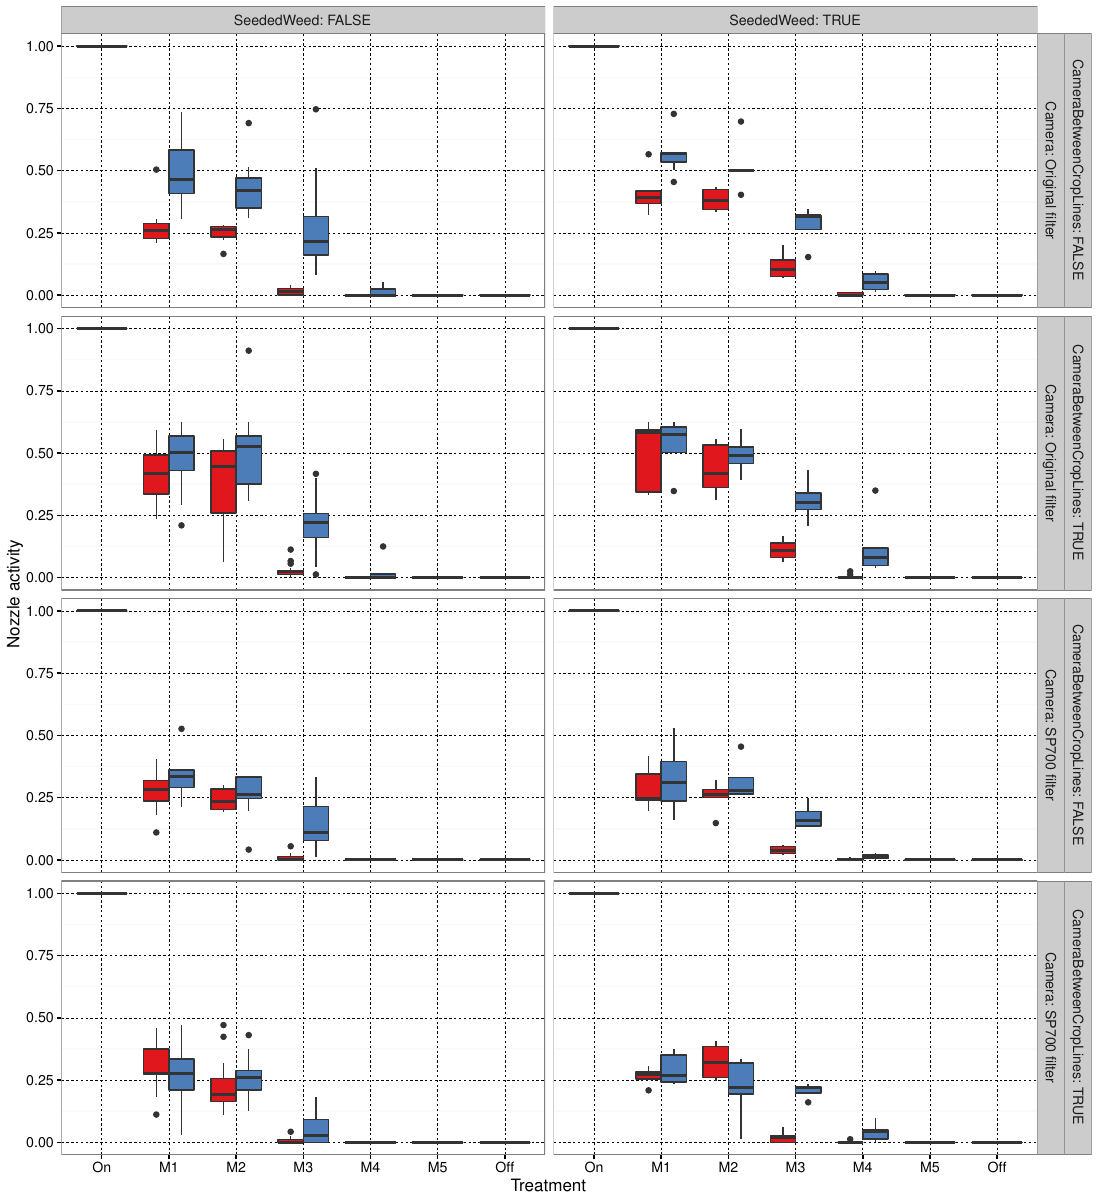
Figure 9. Nozzle activity for each treatment combination. The box plot for the first spraying session is red and the second is